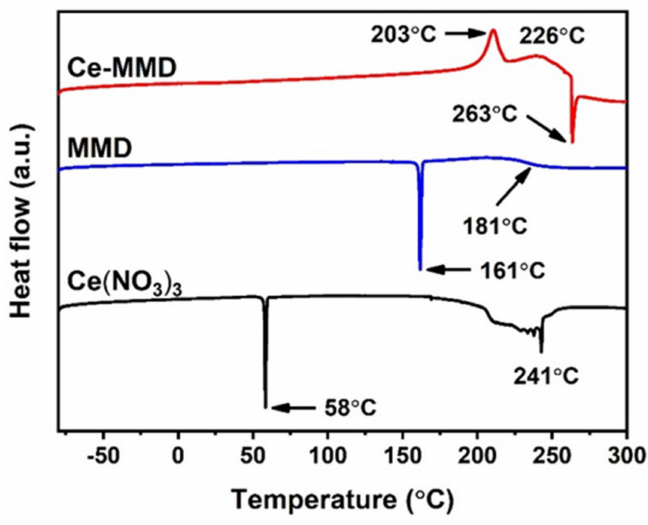
Figure 10. DSC thermograms of cerium(III) nitrate hexahydrate, the MMD ligand, and the Ce-MMD